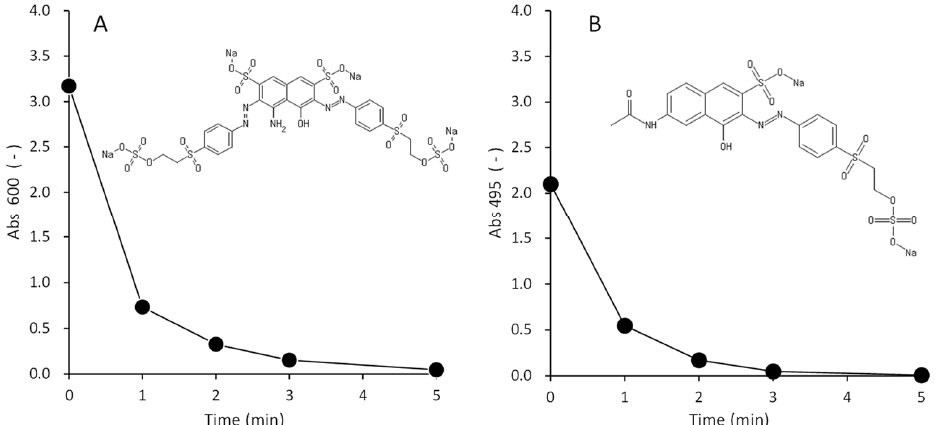
Figure 3. Absorbance at 495 nm and 600 nm of synthetic batik wastewater containing 48 mg/L RB5 and 48 mg/L RO16 during ozonation at 25 °C and pH 12. A600 for RB5 ( A ) and A495 for RO16 ( B ). The absorbance of wastewater treated by ozonation for 10–15 min was less than 0.01.